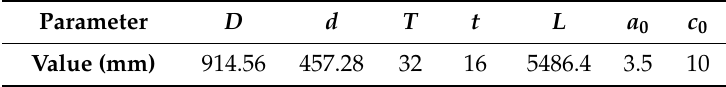
Table 2. The dimensions of the tubular T-joint and the initial crack